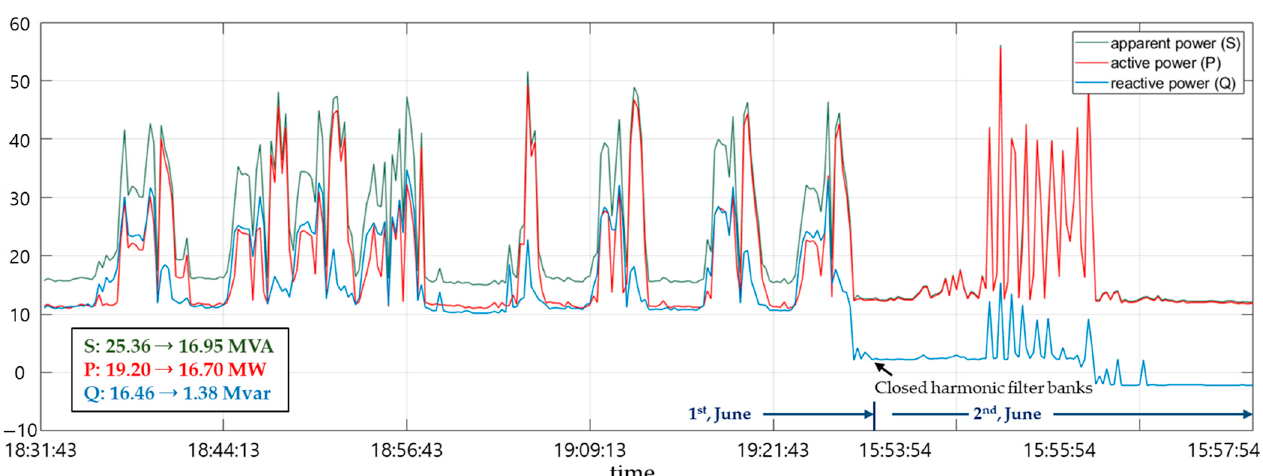
Figure 6. Single line drawing of 22nd HF.